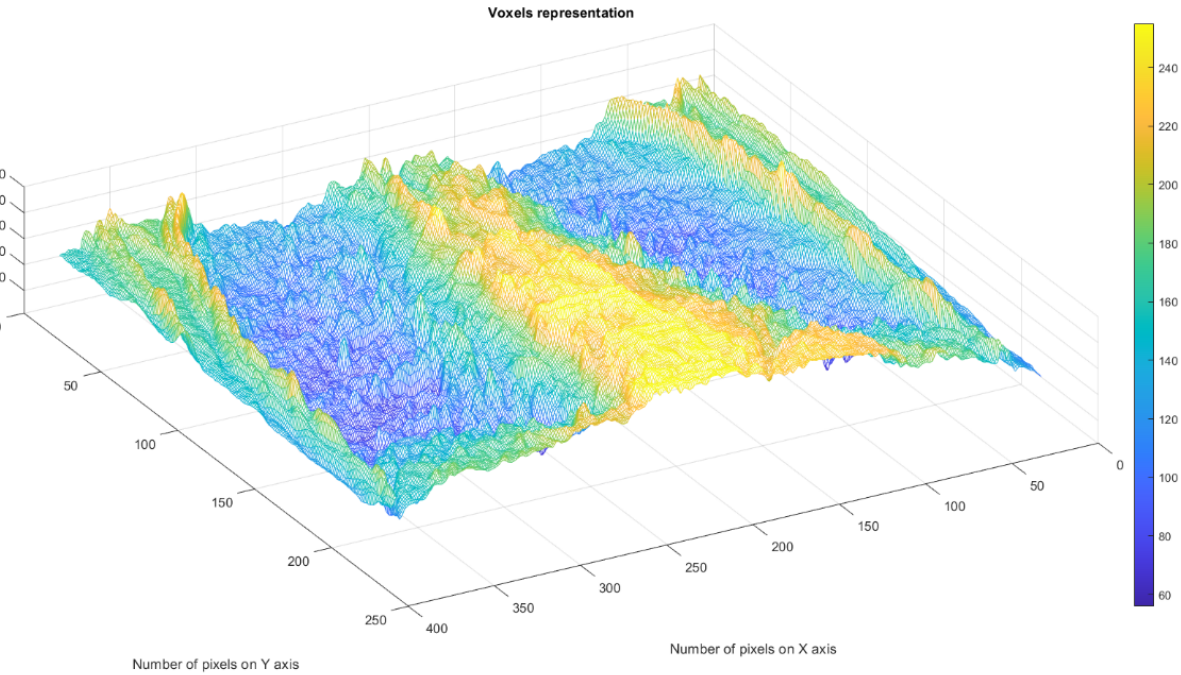
Table 6. Fractal indicators of all fi ve investigated patients